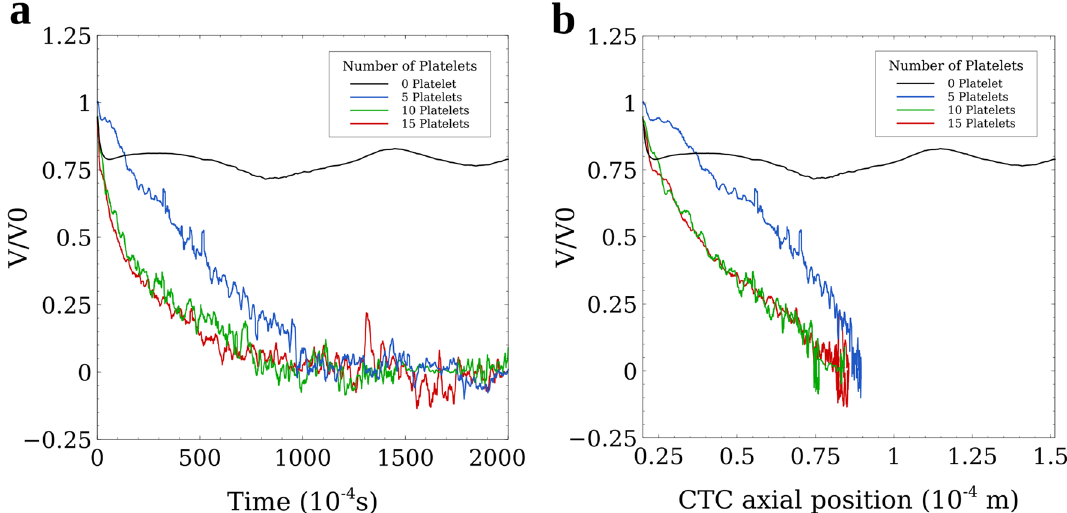
Figure 2. Velocity–Time and Velocity–Axial Position graphs showing that CTC–platelets interactions significantly enhance the formation of the firm adhesion bonds between CTC and the endothelial cell. ( a ) Velocity–Time graph showing the effect of the number of attached platelets on the adhesion of CTCs. With increasing the number of platelets attached to the CTC, the velocity of the CTC decreases faster and the firm adhesion of the CTC to the vessel wall, as a prerequisite for extravasation, occurs in a shorter time. Lodging of the CTC to the vessel wall saves the CTC from further circulation in the vascular system, exposure to the high shear stress in larger vessels, and encountering immune cells. As a result, the faster the CTC adheres to the vessel wall, the higher survival chance it has; ( b ) Velocity–Axial Position of CTC graph showing the distance the CTC rolls and crawls motions in the microvessel until the firm adhesion occurs. Increasing the number of attached platelets reduces the rolling distance which leads to less shear forces exerted on the CTC by endothelial cells and as a result, chances of CTC survival and extravasation